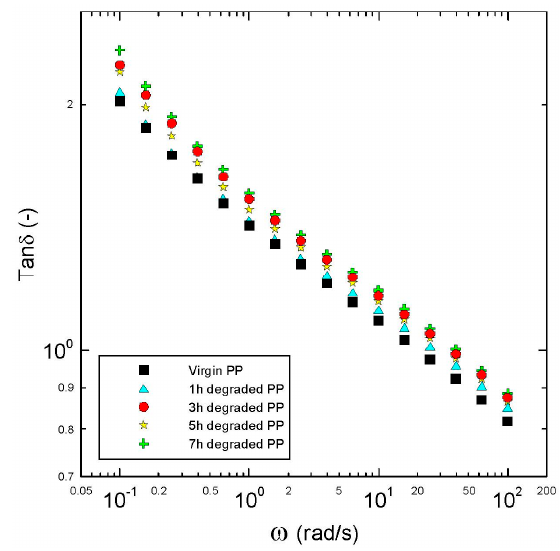
Figure 3. Frequency-dependent Tan δ for virgin and degraded polypropylenes at 180 °C.